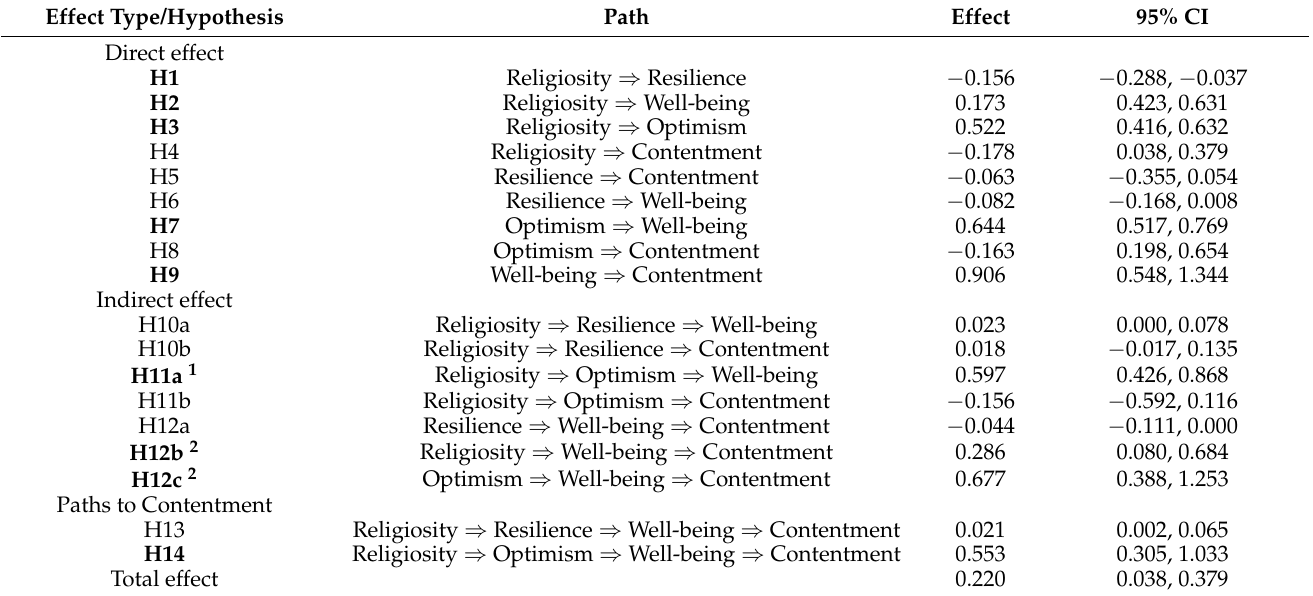
Table 5. Mediating effects of resilience, optimism, and well-being between religiosity and contentment. Effect Type/Hypothesis Path Direct effect